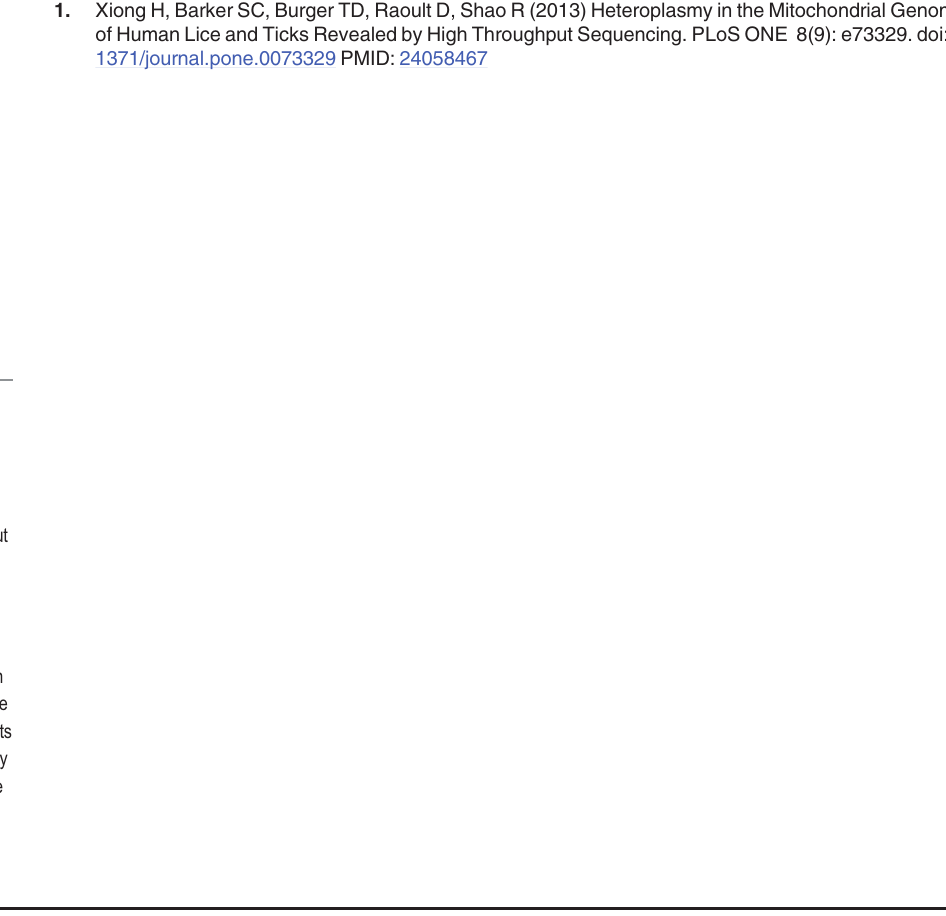
S4 Table. Heteroplasmic sites in mitochondrial tRNA genes of